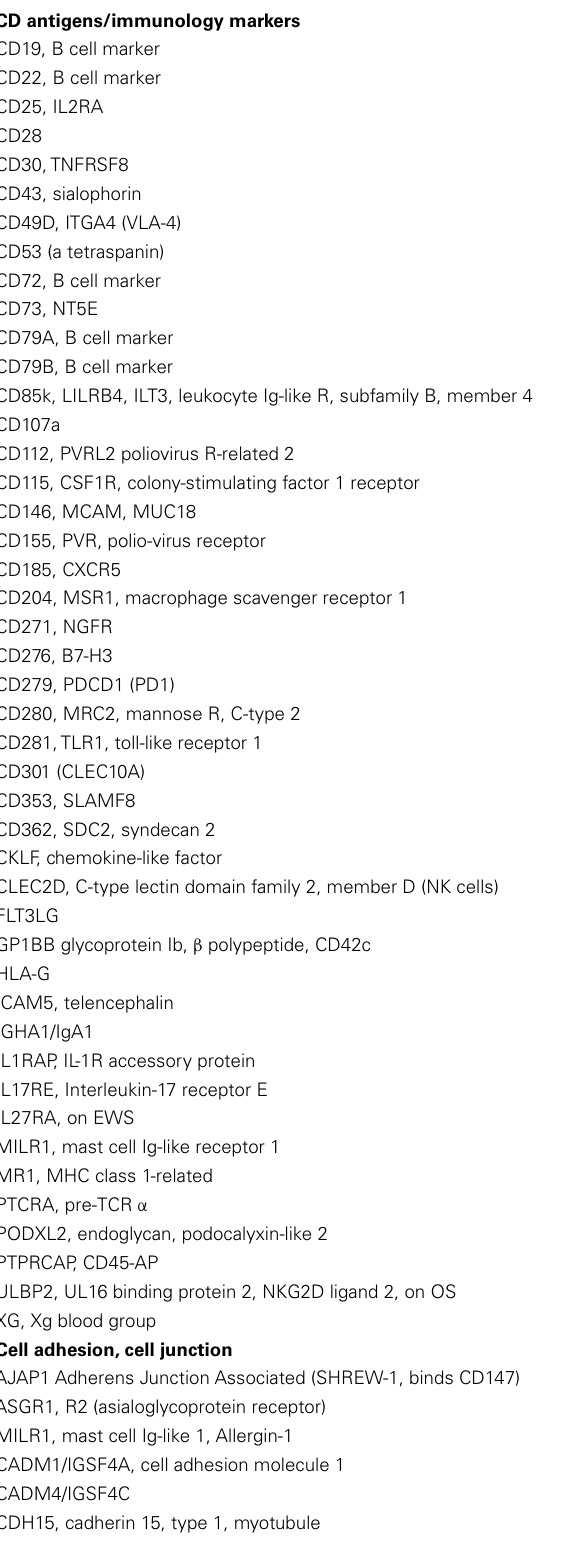
Table 2 |Top 25 pediatric cancer transcripts arranged by